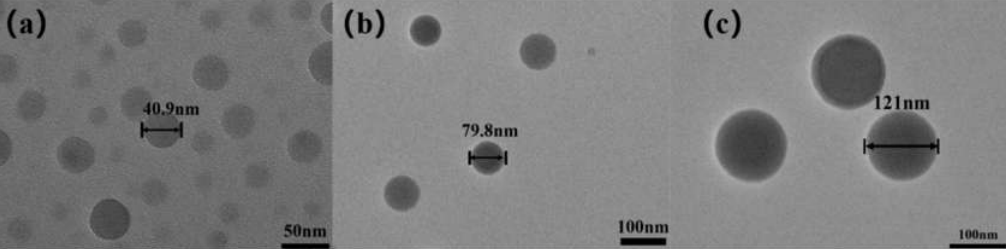
Figure 1. TEM of polystyrene (PS) microspheres at various reaction temperature:( a ) 90 °C, ( b ) 70 °C, ( c ) 50 °C.